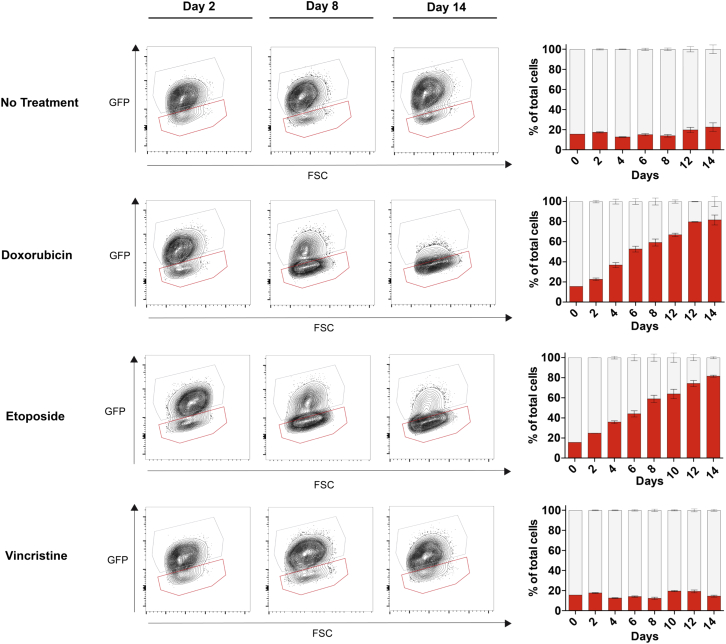
PPM1D Mutants Demonstrate a Selective Advantage In Vitro with Certain Classes of ChemotherapeuticsIn vitro competition was performed with GFP-negative PPM1D mutant cells to GFP-positive control cells at a starting ratio of 15:85. The competing cells were treated with doxorubicin (20 nM), etoposide (250 nM), or vincristine (1 nM) every 4 days, and flow cytometry was performed every 2 days over 14 days to assess the change in percentage of PPM1D mutants. Representative flow plots are depicted at three time points: day 2, day 8, and day 14. The red gate denotes the GFP-negative PPM1D mutant population, and the gray gate denotes the GFP-positive control population. Mean ± SD are shown in the summary graphs (n = 3).